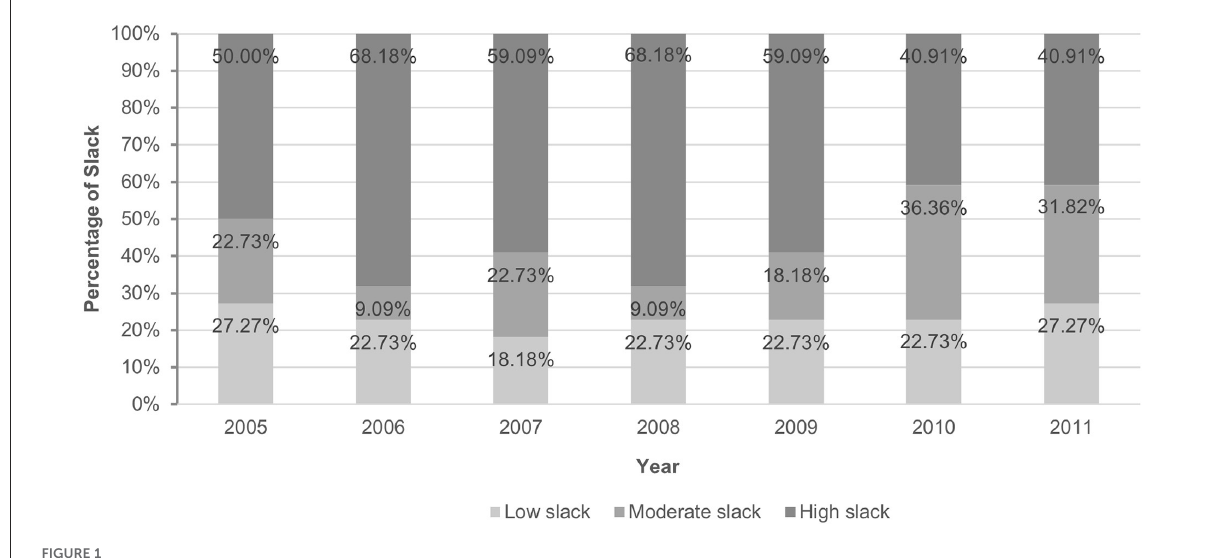
FIGURE1 Status of slack resources in 22 hospitals.